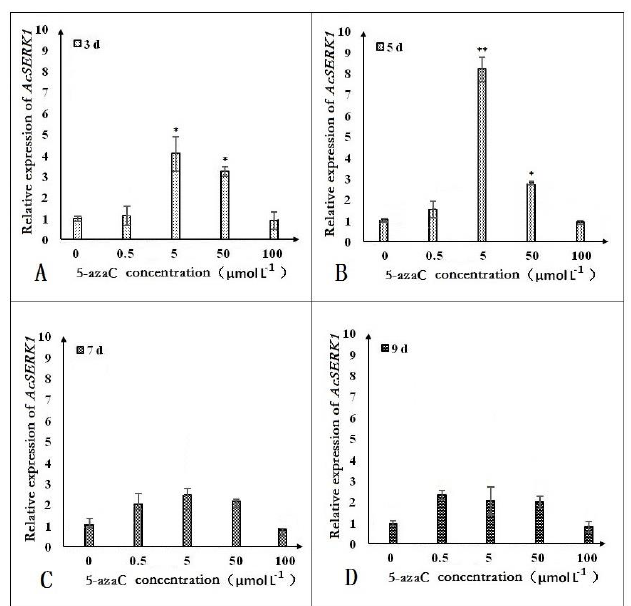
Figure 3. Effect of different concentrations of 5-azaC treatment for different times (3, 5, 7, or 9 days) on the expression levels of AcSERK1 . ( A – D ) The effects of different concentrations on the expression of AcSERK1 during 5-azaC pretreatment at 3, 5, 7, and 9 d, respectively. The data were the average of 3 biological replicates, and the error bars denote the standard error of the mean. The expression differences with different treatments were compared using a one-way ANOVA by SPSS 19.0. * p < 0.01 and ** p < 0.05.